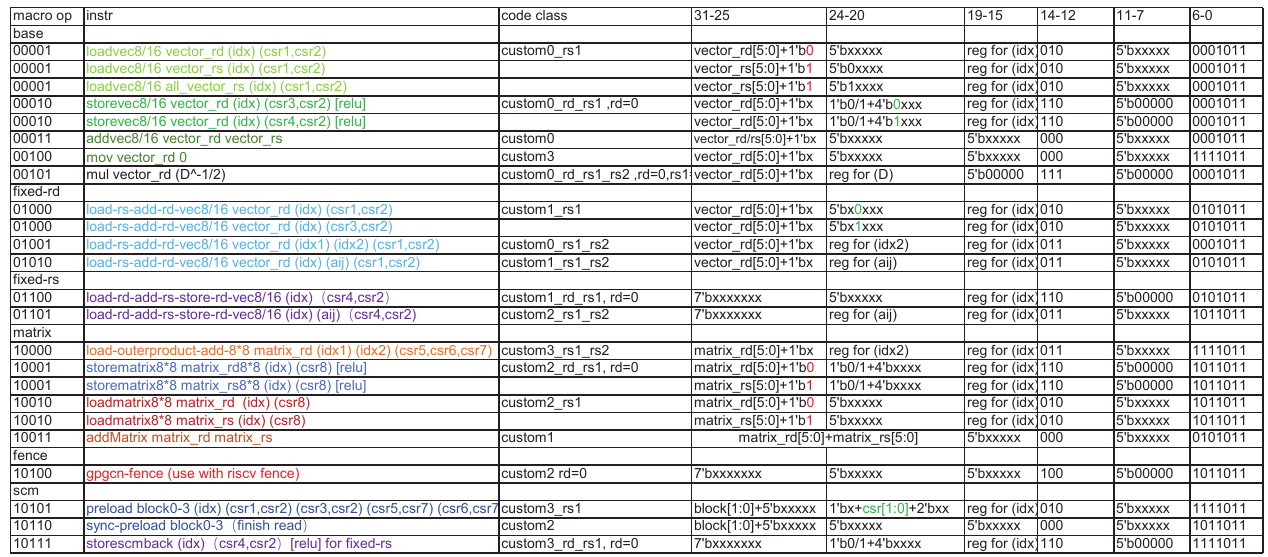
Figure 21. The encoding of GPGCN instruction